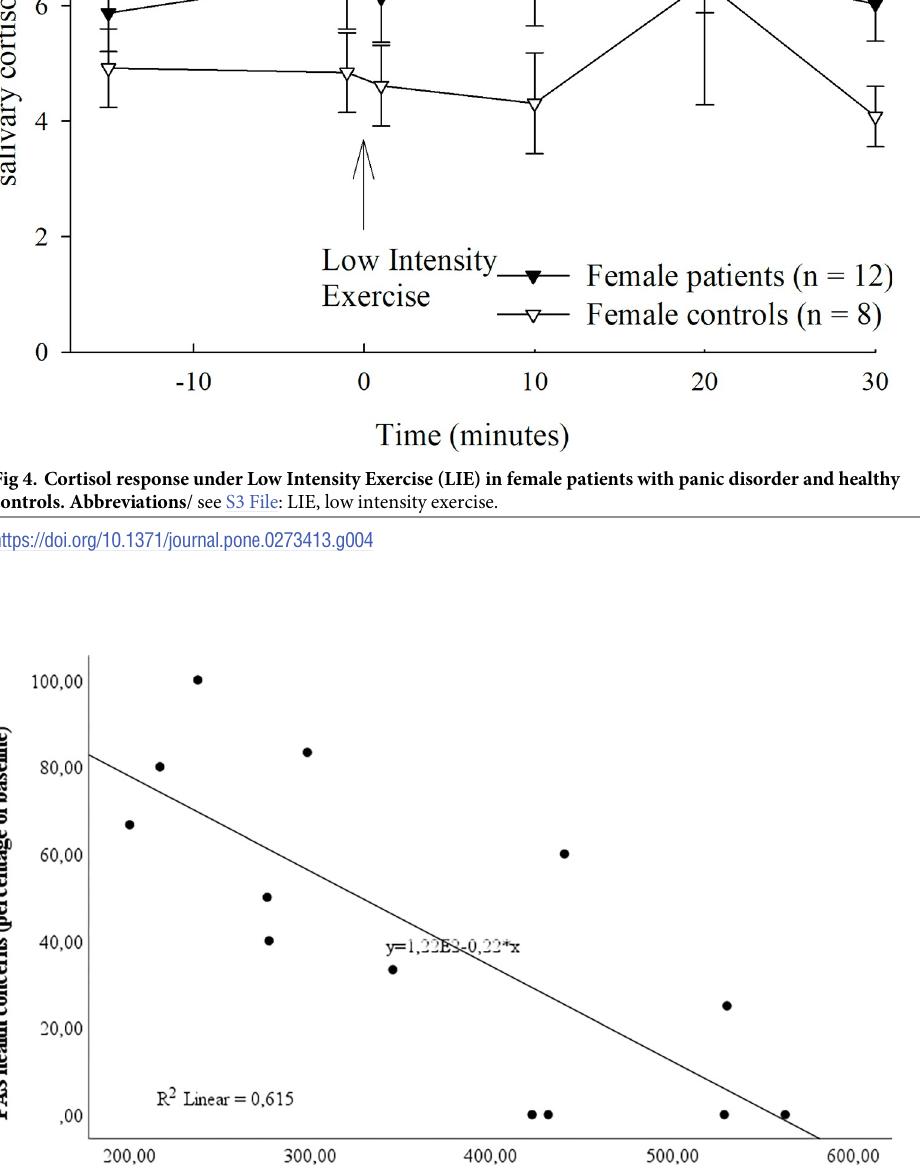
PLOS ONE | https://doi.org/10.1371/journal.pone.0273413 September 1,